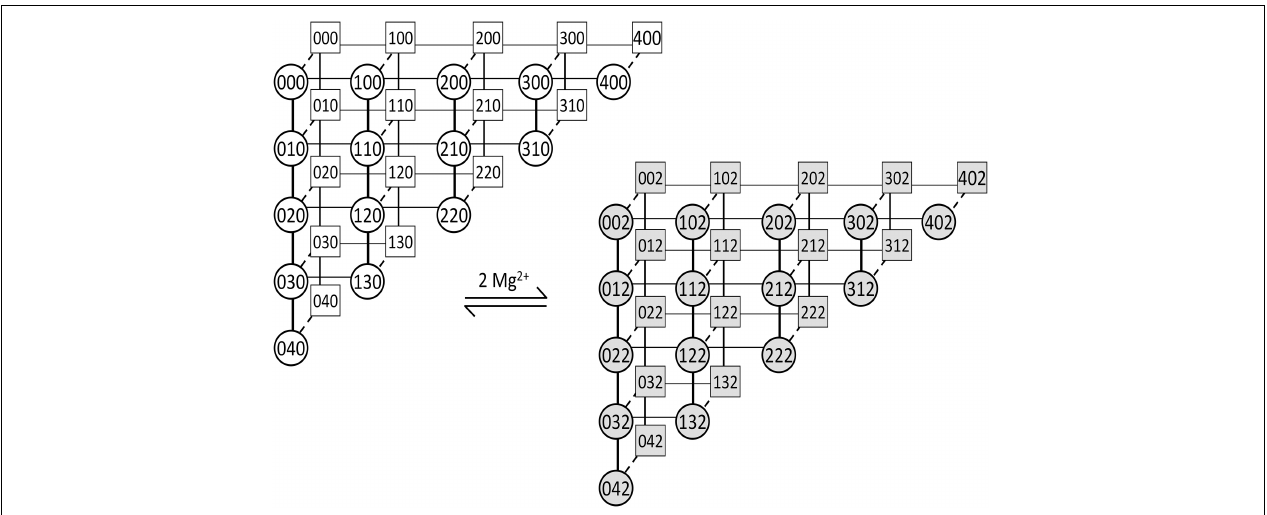
FIGURE 2 | The gating scheme of the MWC-Ca/Mg RyR model. The scheme depicts transitions of four allosterically coupled monomeric activation sites and one common inhibitory site of the RyR channel. The competitive binding of Ca 2 + and Mg 2 + ions to RyR activation sites is shown by horizontal (thin lines) and vertical (thick lines) transitions, respectively. The RyR open/close transitions (dashed lines) are independent of ion binding/unbinding. The RyR inhibitory site binds two Mg 2 + ions simultaneously and switches the RyR channel to a non-conducting state without affecting the activation sites. Squares – closed states; Circles – open states; Gray – inhibited states. The three numerals in the symbols denote (from left to right): the number of Ca 2 + ions bound to the activation site; the number of Mg 2 + ions bound to the activation site; and the number of Mg 2 + ions bound to the inhibition site. All RyR transitions between states are reversible and obey the principle of detailed